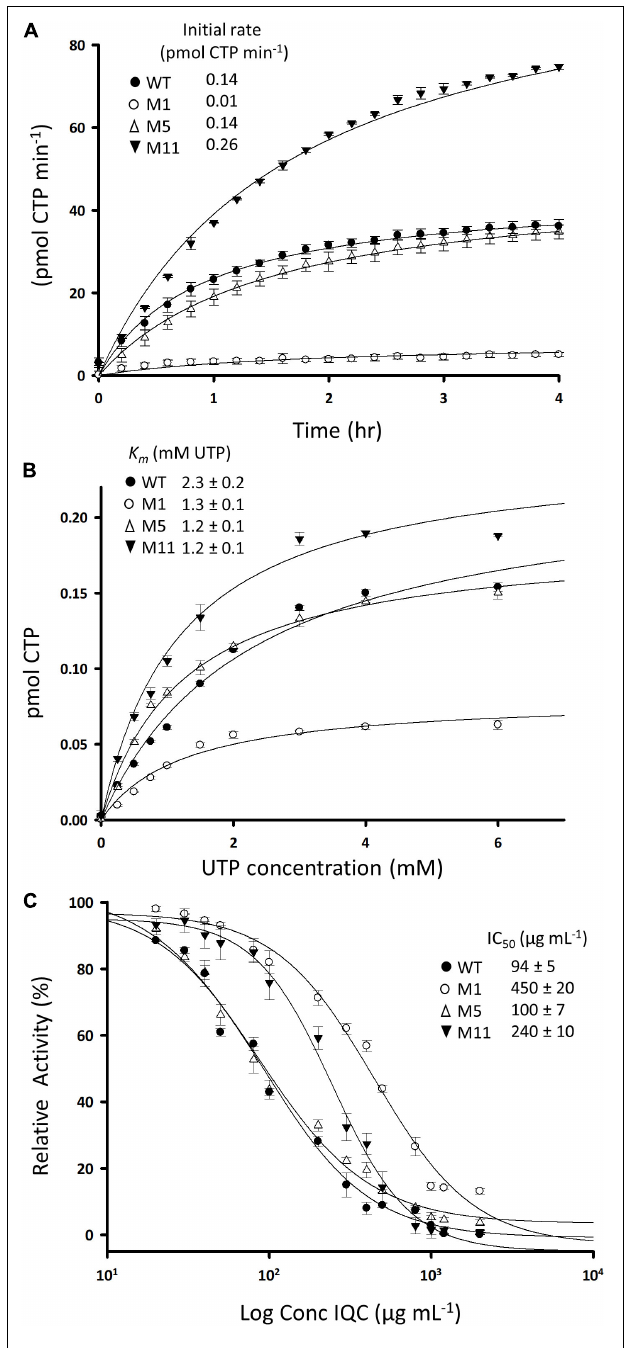
FIGURE 4 | Activities of wild type and mutant CTPS enzymes and the effects of inhibition by IQC. (A) Reaction velocities for the wild type and mutant enzymes. Production of CTP from reactions containing 2 mM UTP was measured by absorbance at 291 nm in the presence of ATP, L-glutamine, and Mg 2 + . (B) Relationship between UTP concentration and reaction velocity in assays equivalent to (A) . Inset shows calculated values for K m . (C) Dose response curves for inhibition of the wild type and mutant enzymes by IQC. Inset shows calculated IC 50 values. The reactions were carried out in triplicate and the data points are the mean of three replicates. Errors are ± standard deviation. The fit curves and the IC 50 values were calculated using SigmaPlot